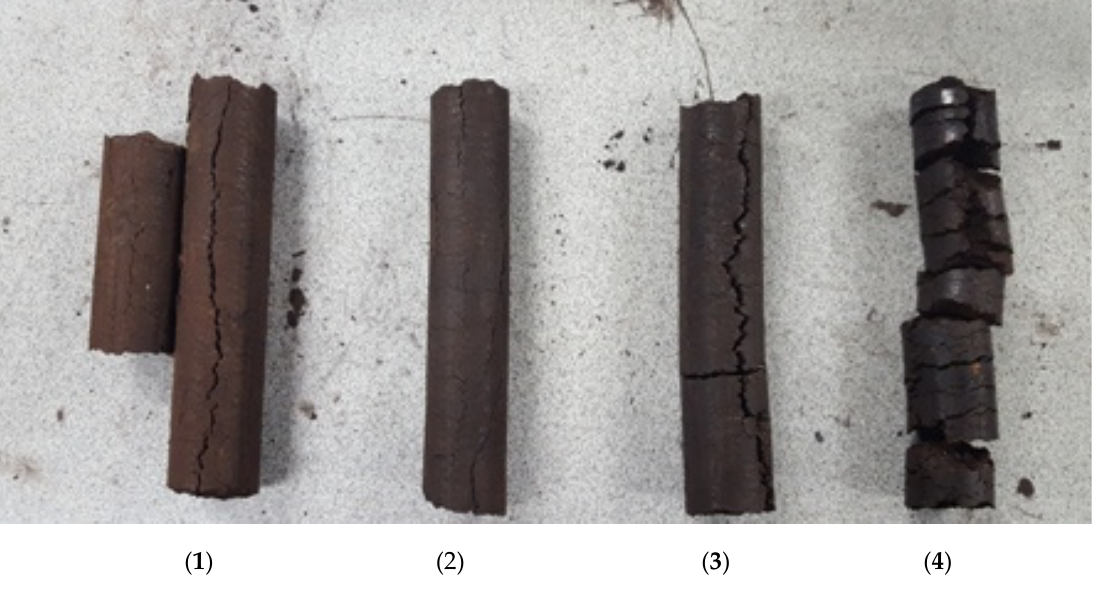
Figure 7. Produced briquettes ( 1 ) LTM, ( 2 ) mix-10.75% moisture, ( 3 ) mix-14% moisture, and ( 4 ) mix-16% moisture.